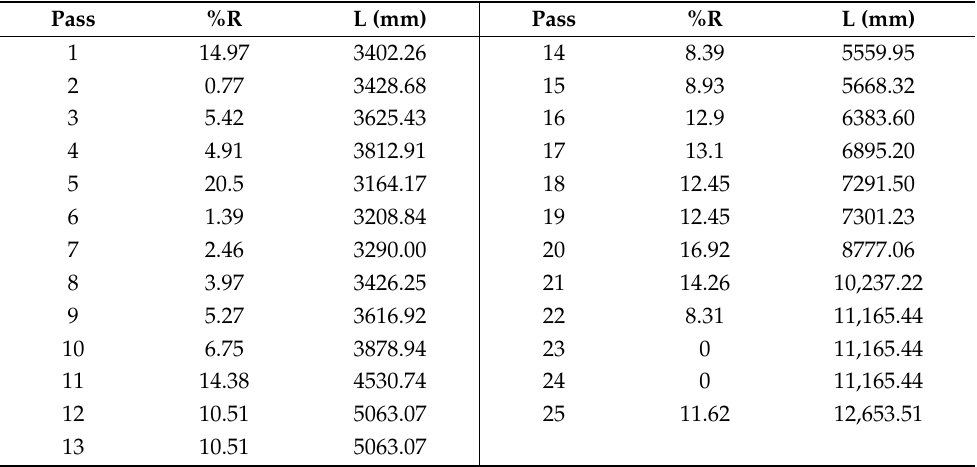
Figure 3. Gap between work rolls per pass and location of the beam through the rolling sequence. Table 3. Analytical predictions of % R and final length per